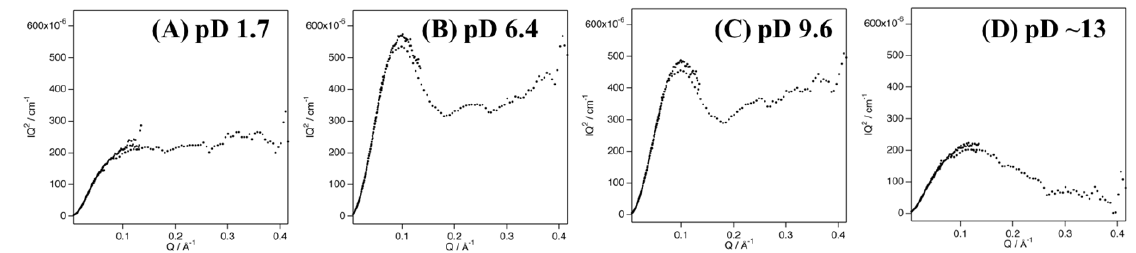
Figure 4. Kratky plots of the SANS curves of Cyt c ’ at pD 1.7 ( A ), 6.4 ( B ), 9.6 ( C ), and ~13 ( D ). In SANS curves, the extrapolated intercept intensity (I(0)) is proportional to the mo- ular weight (MW) and the weight concentration (C) of the scattering lecular weight (MW) and the weight concentration (C) of the scattering molecules.